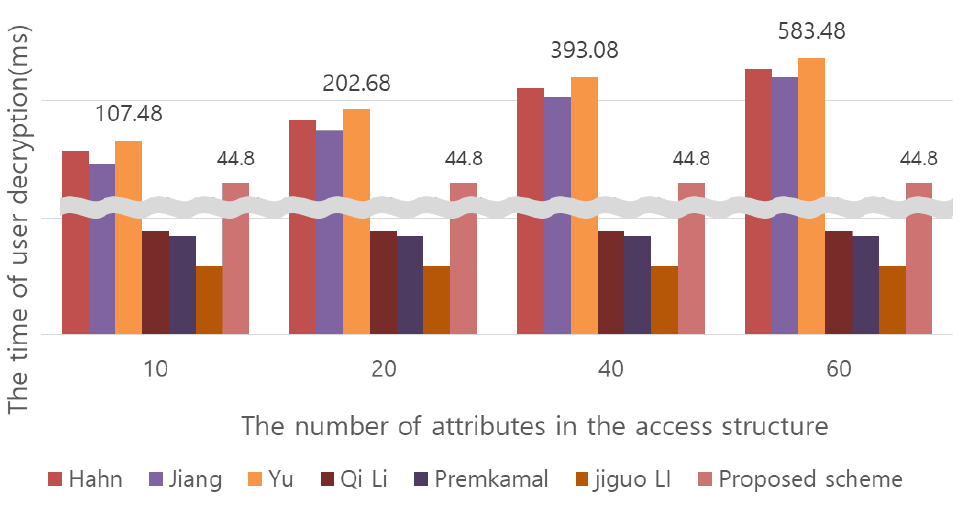
Figure 12. Comparison of data decryption time between existing CP-ABE schemes and the proposed scheme.